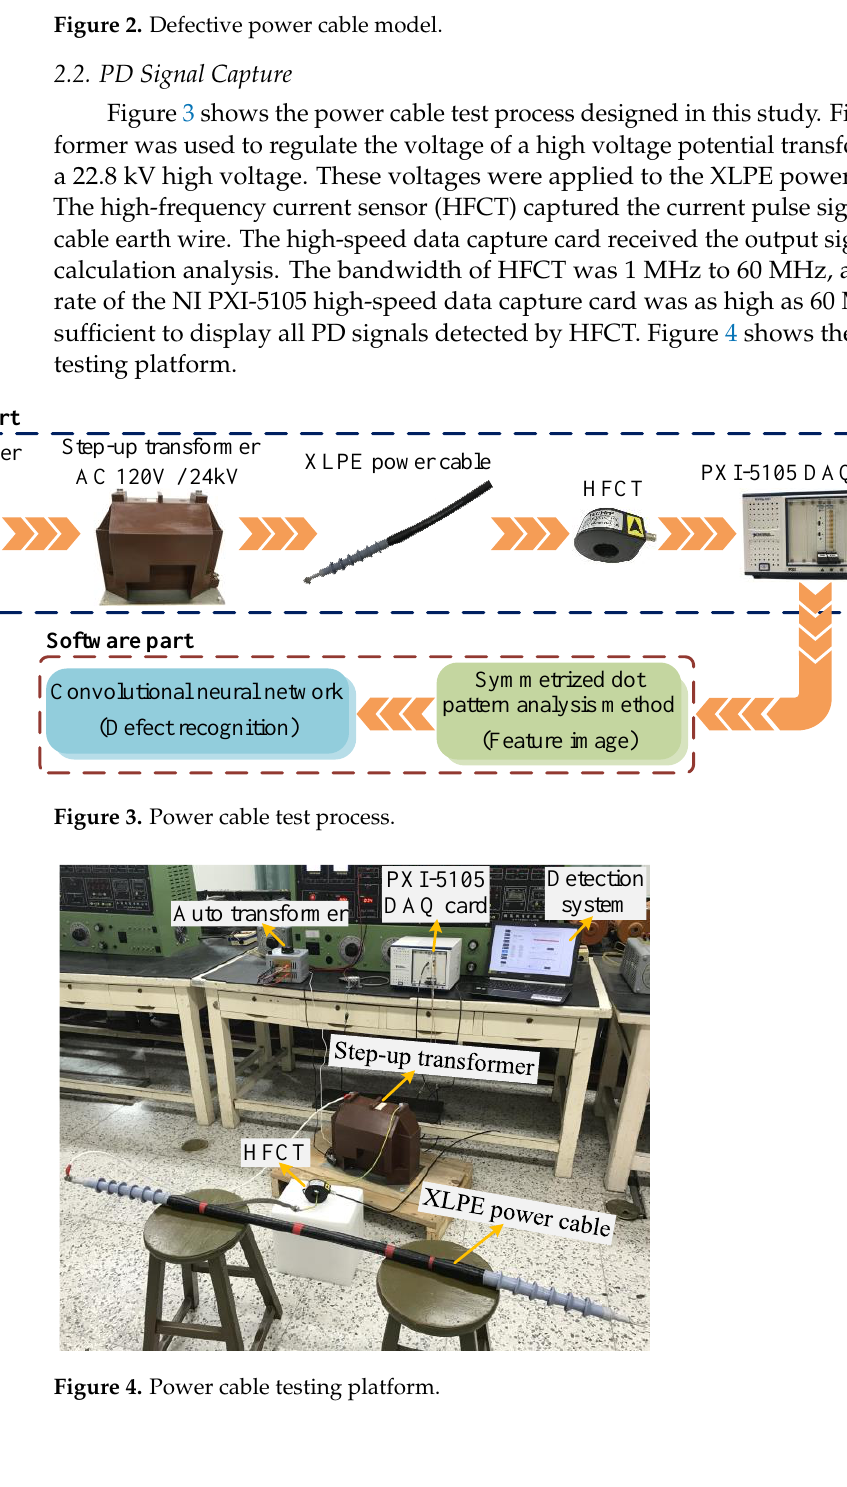
Figure 2. Defective power cable model.